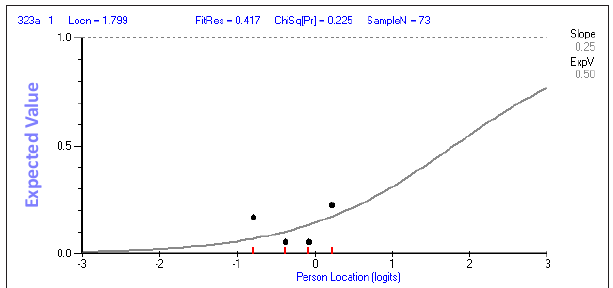
FIGURE 8: Item characteristic curve (Item